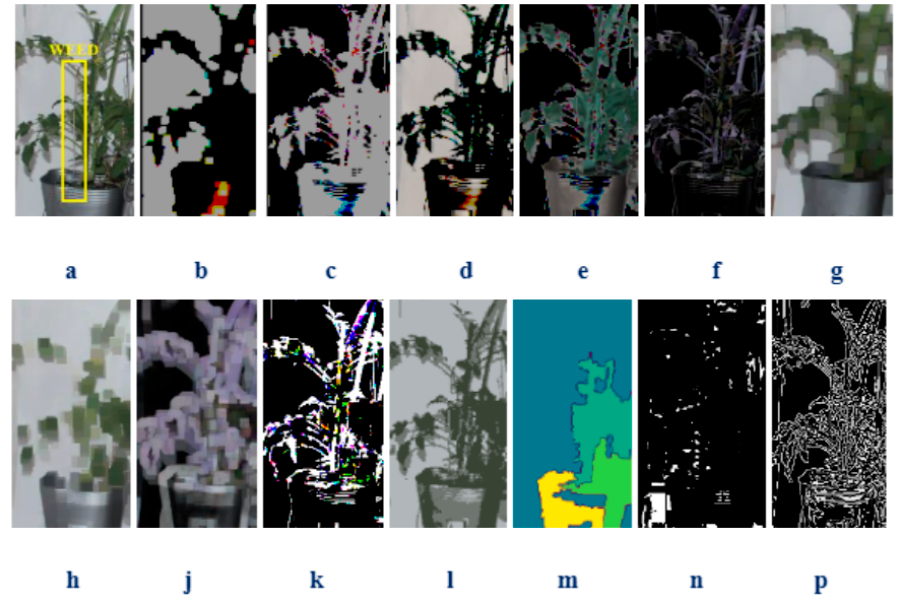
Figure 2. Examples of feature extraction: ( a ) received image with weed and tomato, ( b ) image